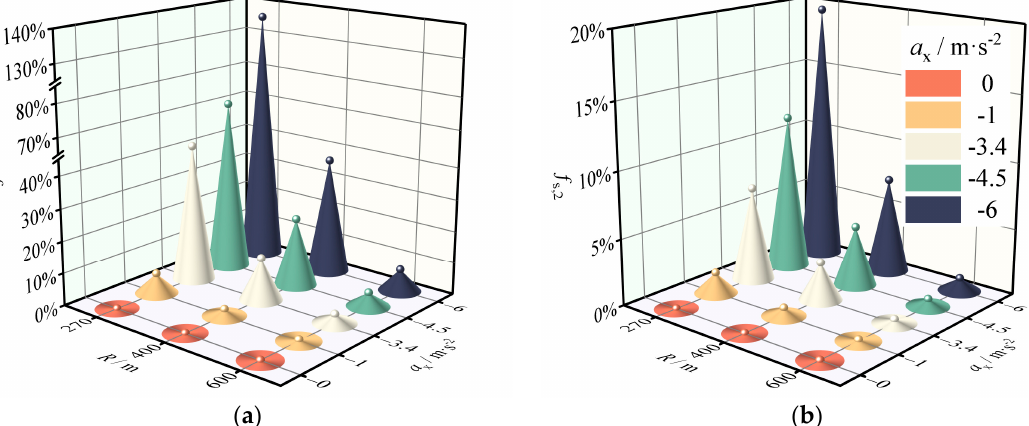
Figure 7. Safety margin reduction rate of the SUV on the horizontal curve and grade combinations under braking. ( a ) Sideslip margin reduction rate. ( b ) Rollover margin reduction rate.